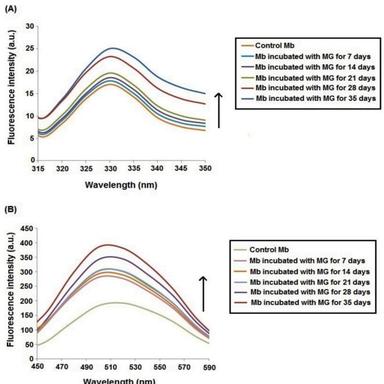
Spectrofluorimetric study. Tryptophan fluorescence emission for control Mb ( ) and Mb incubated with MG for 7 days ( ), 14 days ( ), 21 days ( ), 28 days ( ) and 35 days ( ) recorded in the 315–350 nm range following excitation at 295 nm. Protein concentration was adjusted to 5 μM for recording the spectra. ANS fluorescence emission for control Mb ( ) and Mb incubated with MG for 7 days ( ), 14 days ( ), 21 days ( ), 28 days ( ) and 35 days ( ) recorded in the 450–590 nm range. The protein samples (5 μM eac